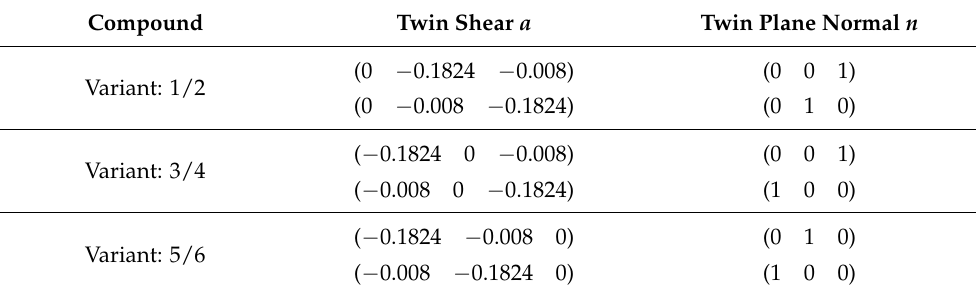
Table 2. Twin elements for compound twins with different variant combinations.